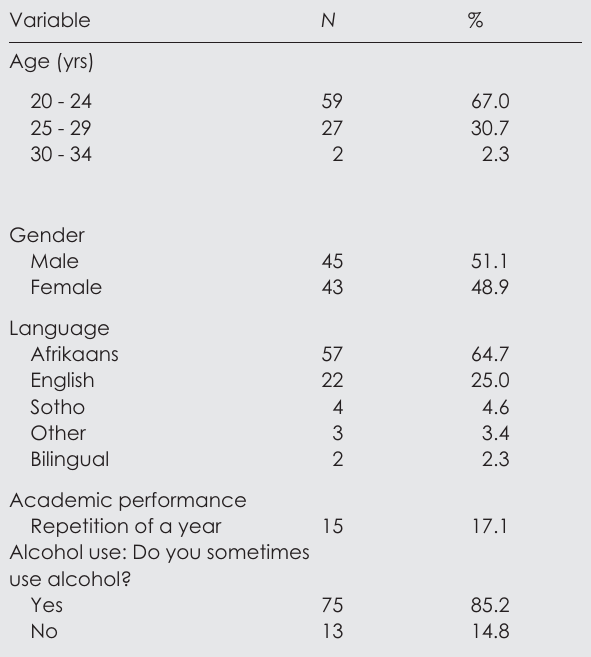
Table I. Demographic data on respondents ( N =